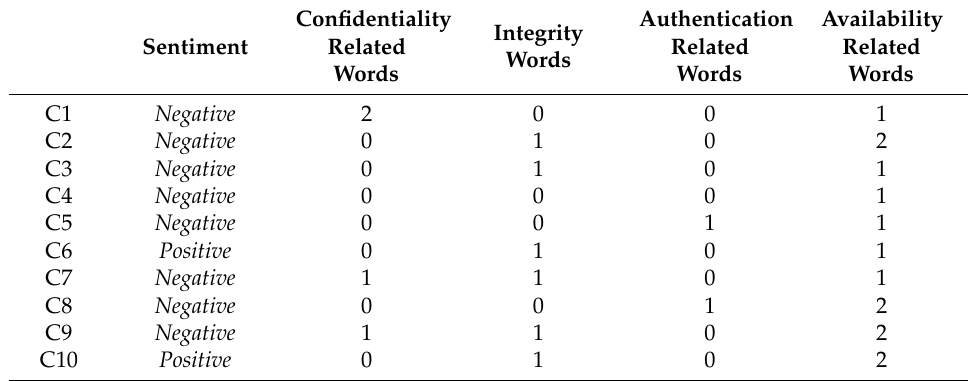
Table 2. Distribution of security-related